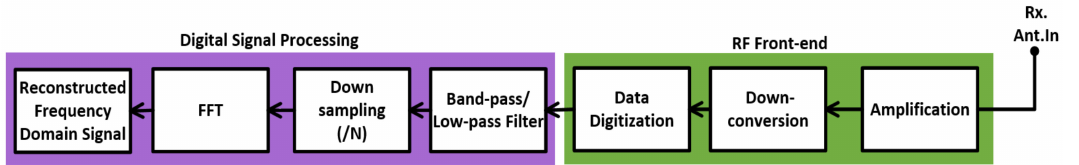
Figure 5. Overview of SDR hardware and software receiver